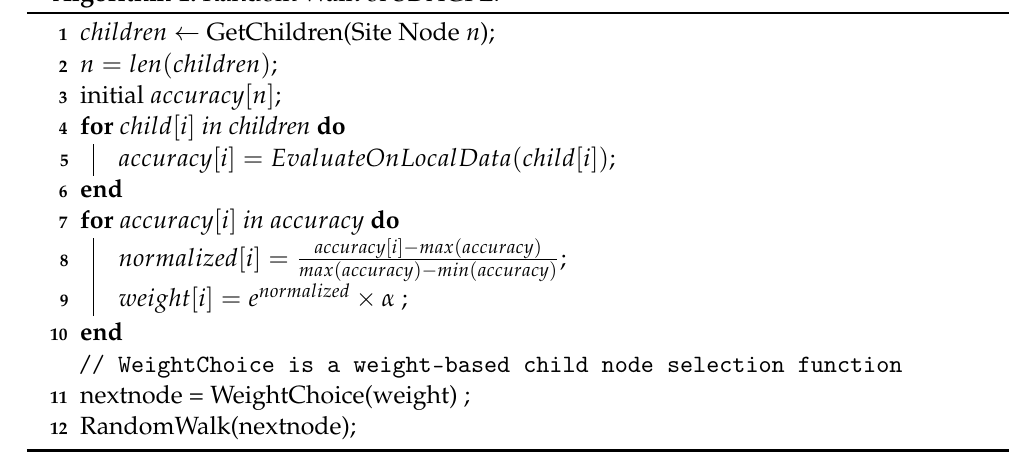
Algorithm 1: Random Walk of